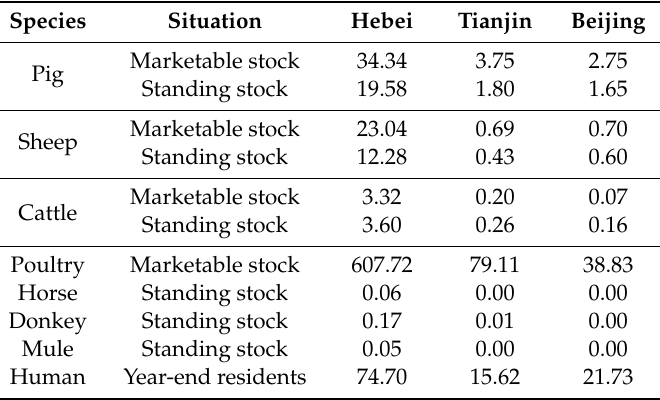
Table 6. The quantity of humans, livestock, and poultry in 2016 (10 6 ) (source: http: // www.stats.gov.cn / ).